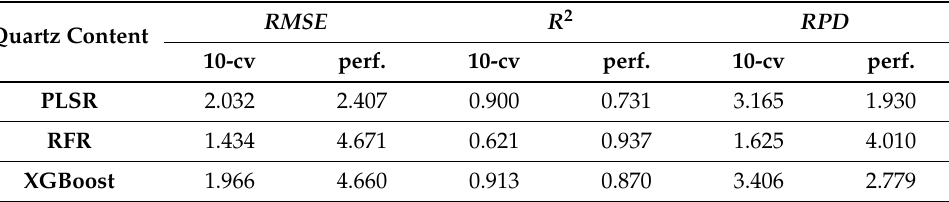
Table 2. Results of the 10-fold cross-validation (10-cv) and results of the performance dataset (perf.) for the quartz content of ML